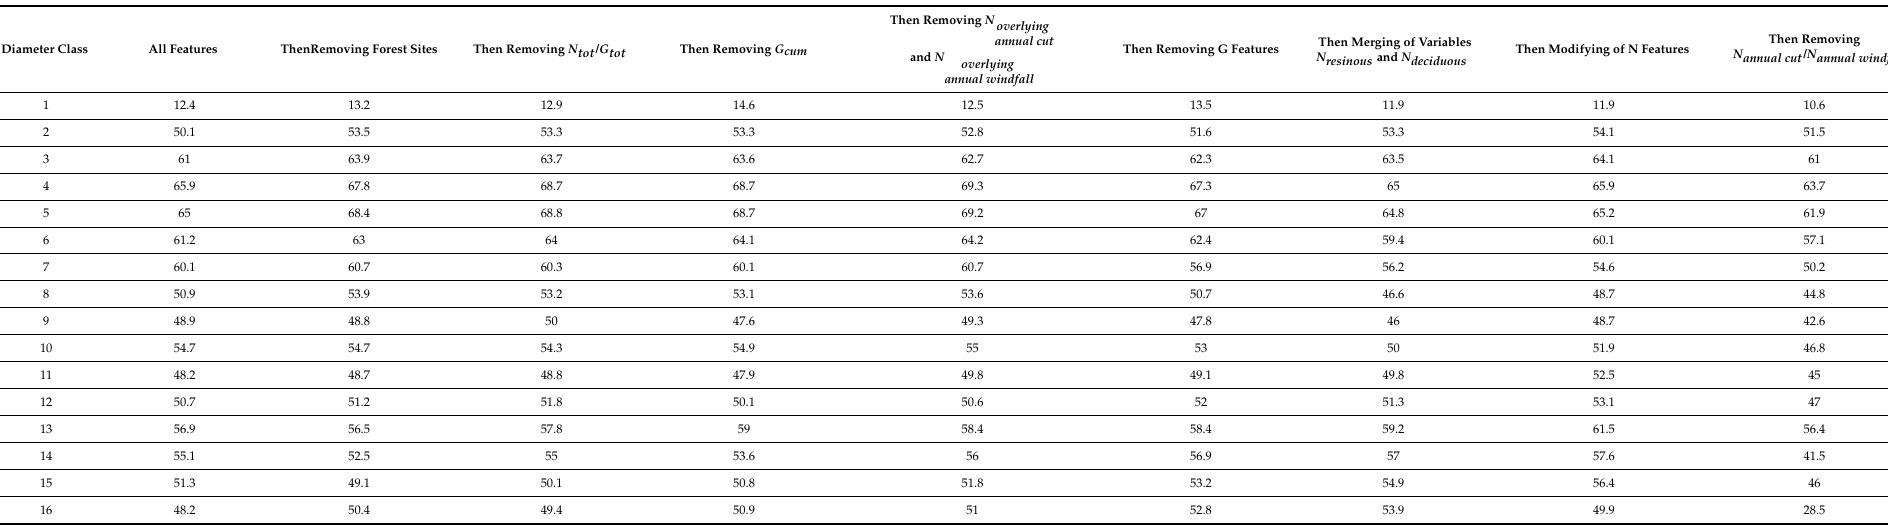
Table A2. Results of the Stepwise Regression with Backward Elimination; values are test R 2 for the respective models corresponding to the 16 different diameter classes; these results are based on the optimal features transformation and the optimal regressor presented in Section 3.1.2; the columns correspond to different sets of features, starting with all features in the left column and progressively and cumulatively eliminating or modifying groups of features going to the right; the bold column corresponds to the set of features selected for the final models in this study; all values are averaged on 10 different train-test